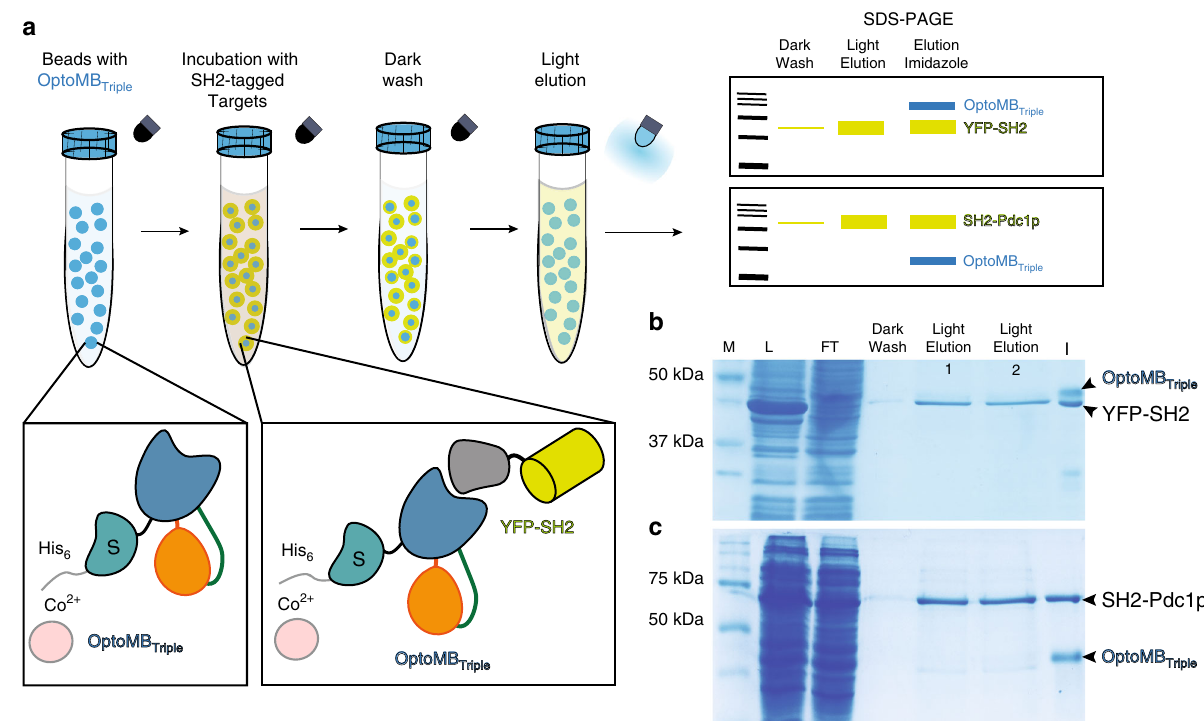
Fig. 4 Light-controlled af fi nity chromatography (LCAC) to purify SH2-tagged proteins using cobalt-immobilized OptoMB. a Schematic diagram of functionalization of LCAC Co 2 + -agarose beads using His 6 -OptoMB V416I_G528A_N538E (OptoMB Triple ) containing a SUMO tag (S) and LCAC procedure involving dark incubation of crude E. coli extract containing YFP-SH2, washing in the dark, and eluting with blue light in batch or column (Supplementary Fig. 4). SDS-PAGE was used to resolve the fractions from each puri fi cation step. b , c SDS-PAGE gel of LCAC-puri fi ed YFP-SH2 ( b ) and SH2-Pdc1p ( c ). Molecular weight markers (M), lysate (L), unbound fl ow through (FT), washing step in the dark (Dark Wash), two consecutives light elution aliquots (Light Elution 1 and 2), and the imidazole elution (I) were resolved in 12% SDS-PAGE. Puri fi cations were repeated at least three times observing similar